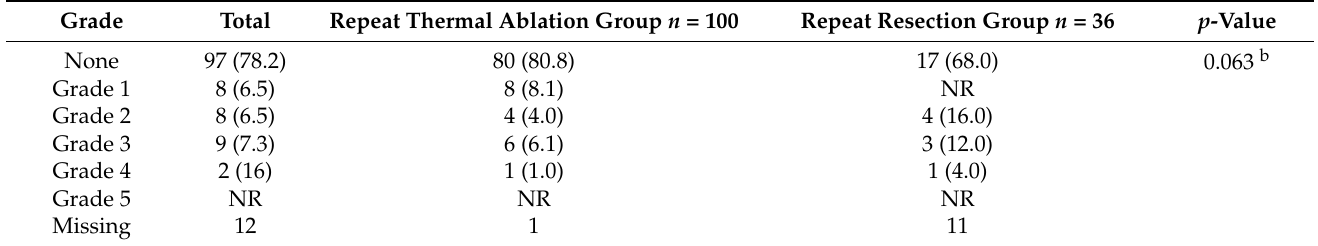
Table 3. Complications of repeat local treatment (CTCAE)